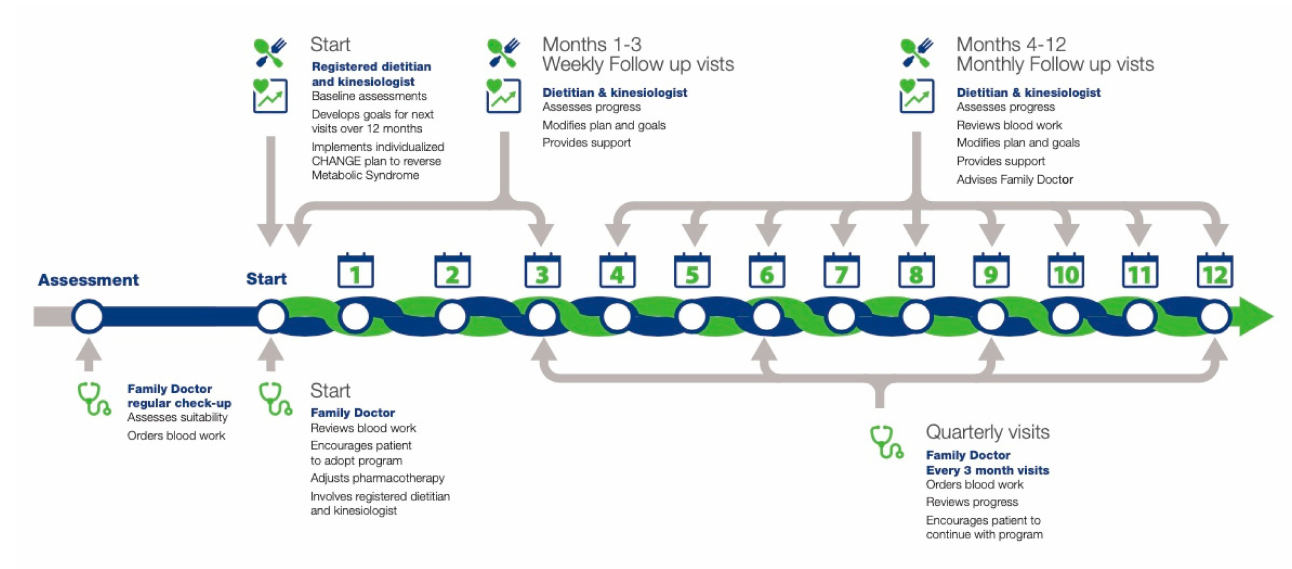
Figure 2. The CHANGE program